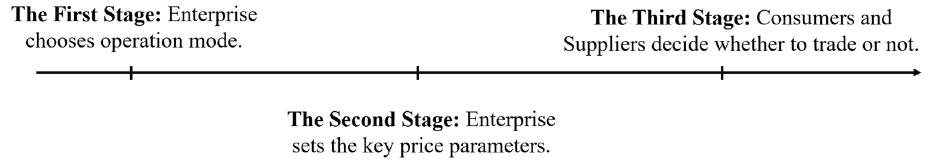
Figure 3. Game sequence diagram for the selection of operating enterprise mode.